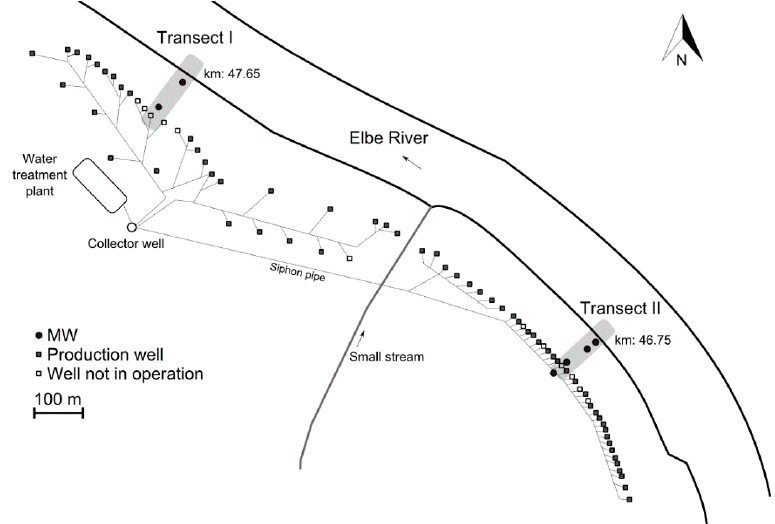
Figure 2. Location map water works Dresden–Tolkewitz.